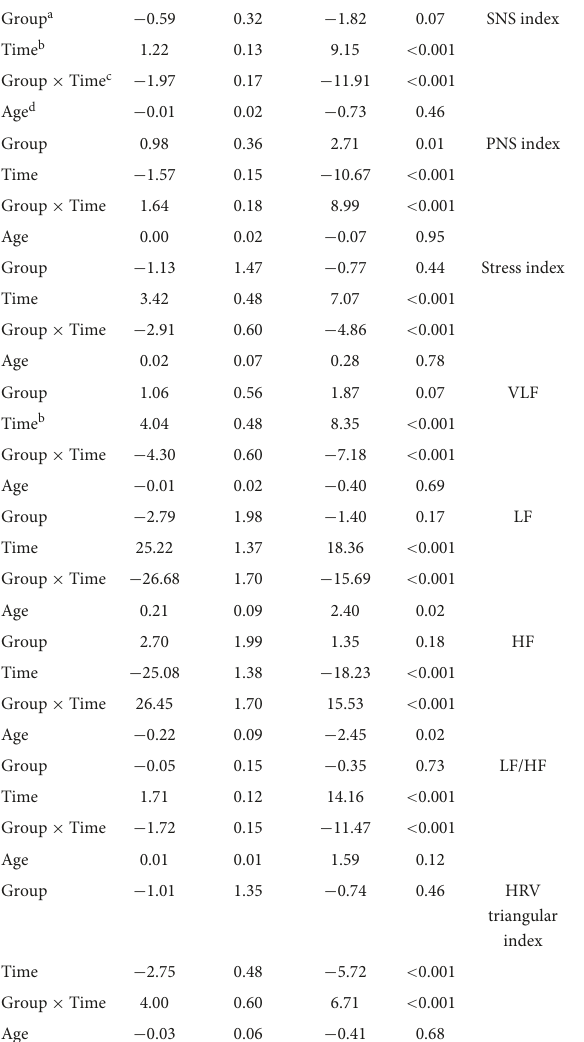
TABLE 4 Linear mixed effect models of the results obtained from HRV. t -value P -value Outcomes Estimate Standard error